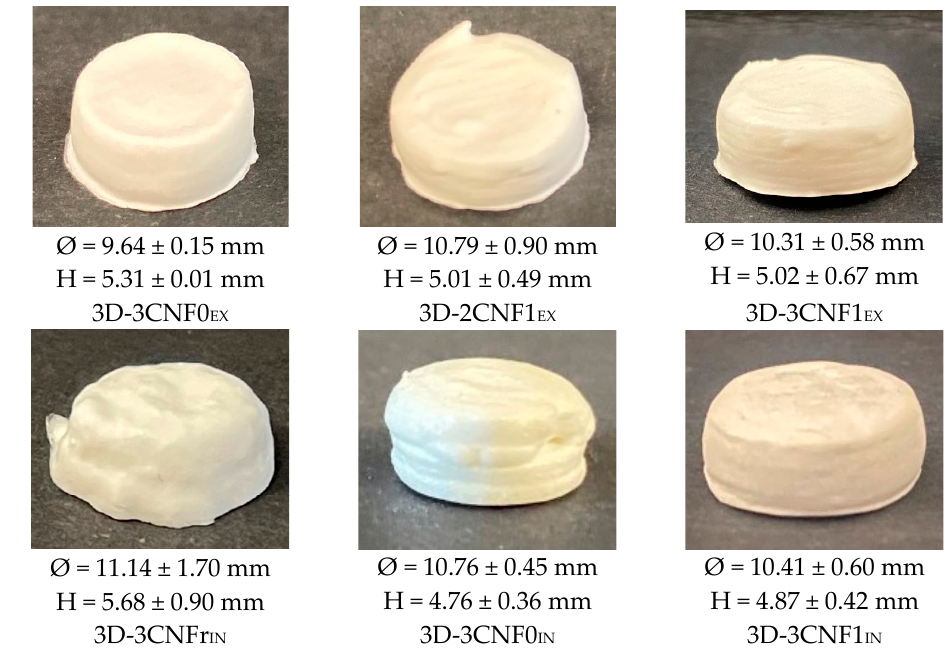
Figure 6. Photographs of 3D-printed cylinders from WBPUU/CNF inks.